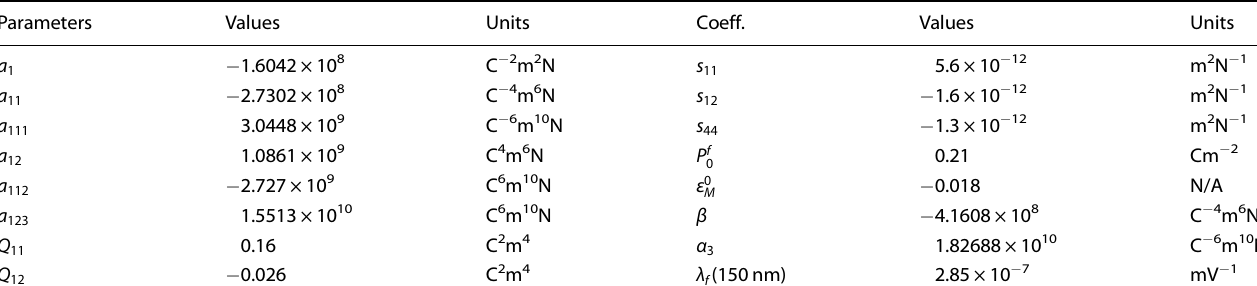
Table 2. Parameters of KNN fi lms used in theoretical computations of this work 35 . Parameters Values Units Coeff.